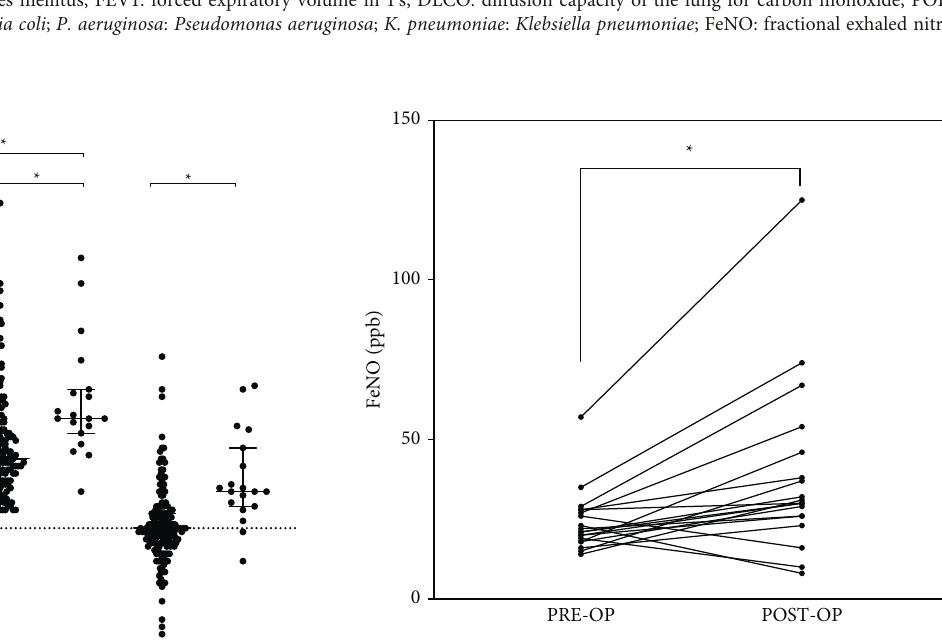
Figure 3: For the patients developed with POP, a trend toward increased FeNO levels was noted ( P < 0 . 001). FeNO: fractional exhaled nitric oxide; PRE-OP: preoperation; POST-OP: